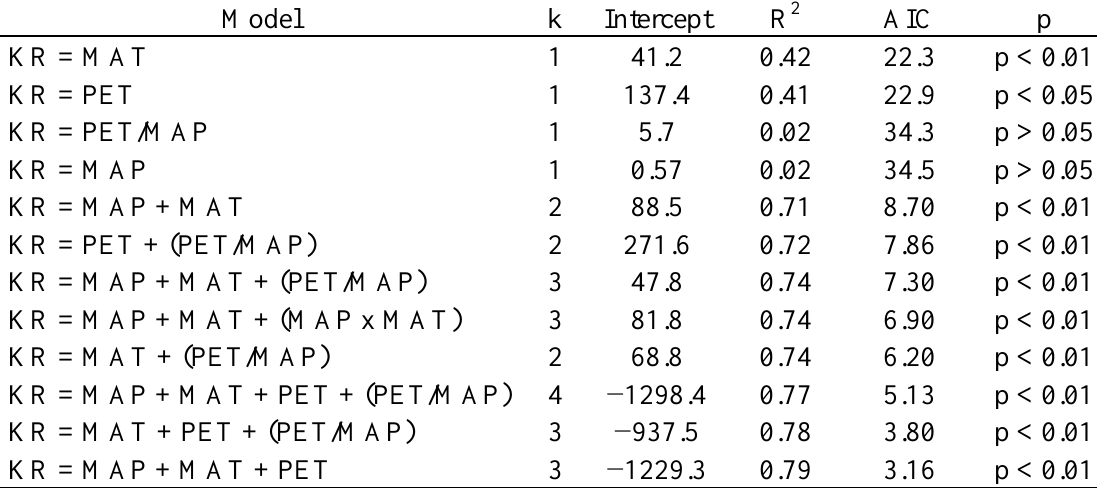
Table 3. Model selection through stepwise regression for healthy:unhealthy koa ratio (KR) predictions using optimum combinations of environmental factors. k = number of factors, AIC = Akaike Information